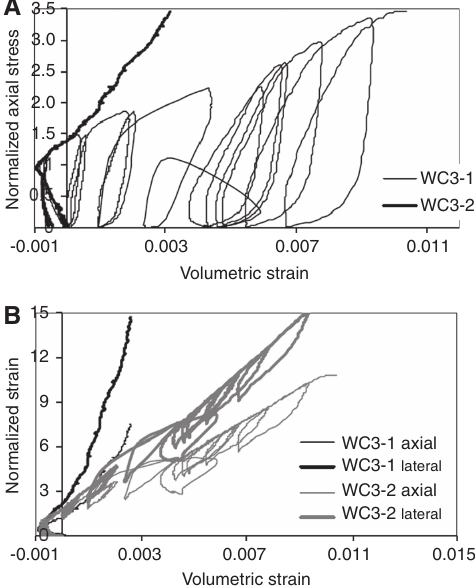
Figure 6 WC2 specimens: (A) normalized axial stress versus volu- metric strain, (B) normalized strain versus volumetric strain.